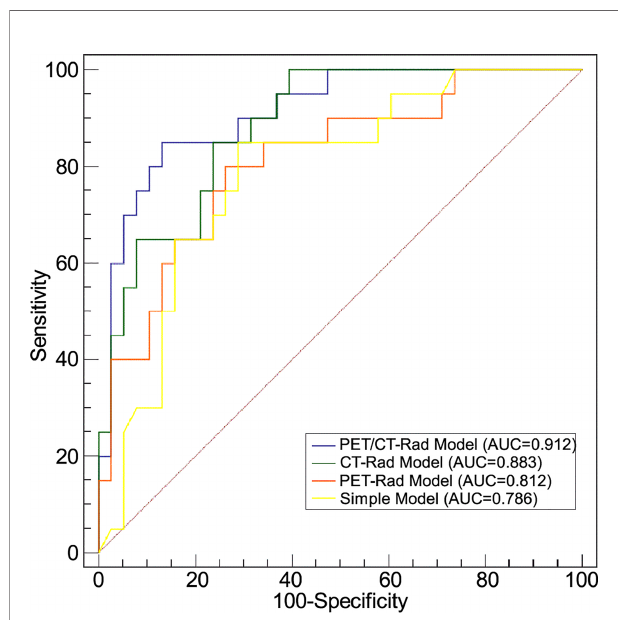
FIGURE 5 | Receiver operating characteristic analyses of four predictive models for IDH genotype